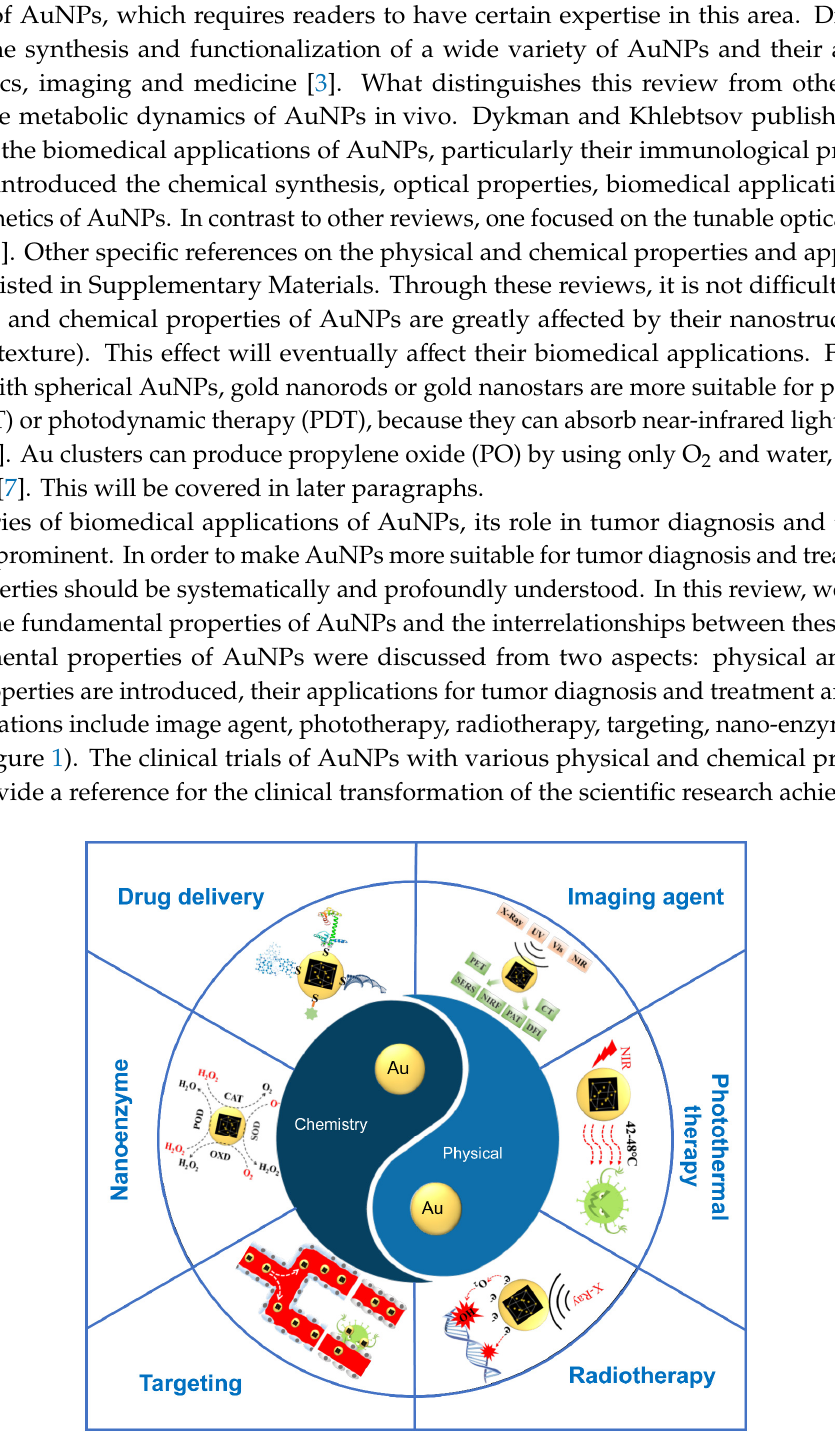
Figure 1. Applications for tumor diagnosis and treatment based on the basic physical and chemical properties of gold nanoparticles (AuNPs). 75